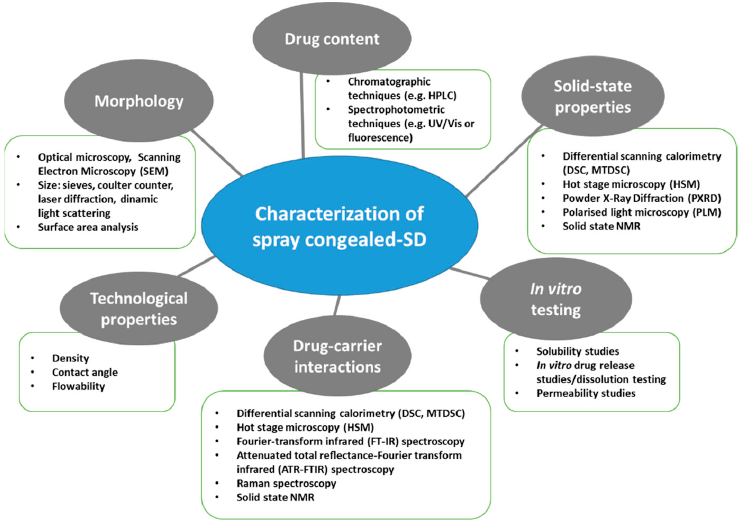
Figure 4. Schematic classification of the most commonly used techniques for the characterization of spray congealed SD.